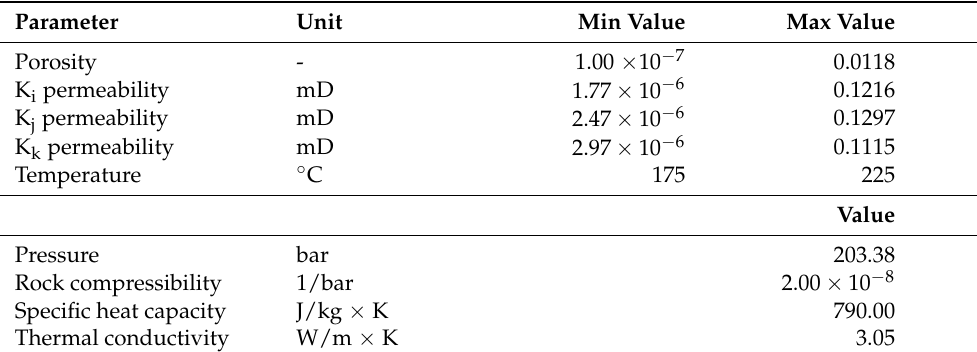
Table 2. Summary of the reservoir properties for the simulation model [2].